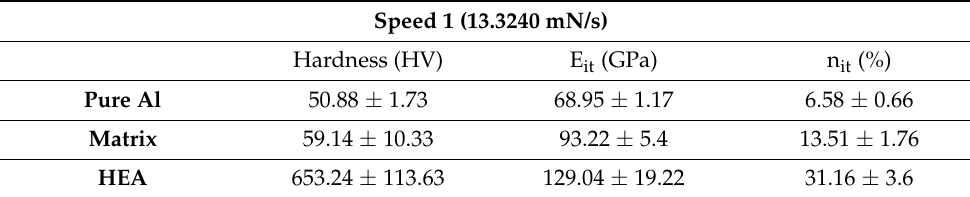
Table 2. Nanoindentation based fundamental mechanical properties (loading speed 6).